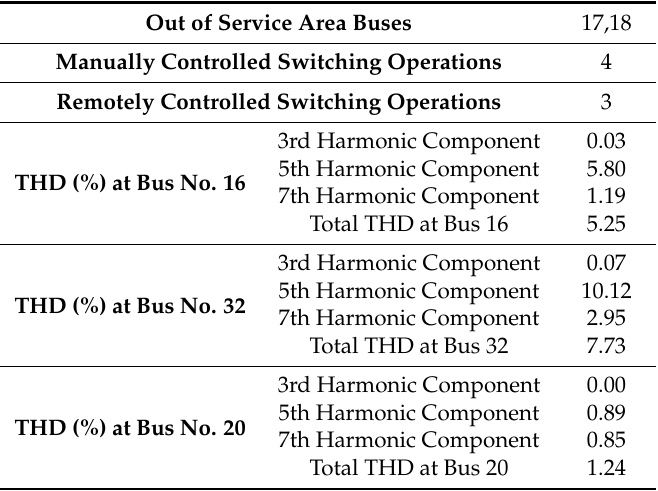
Table 5. Optimal values obtained through Non-Dominated Sorting Genetic Algorithm-II (NSGA-II) restoration